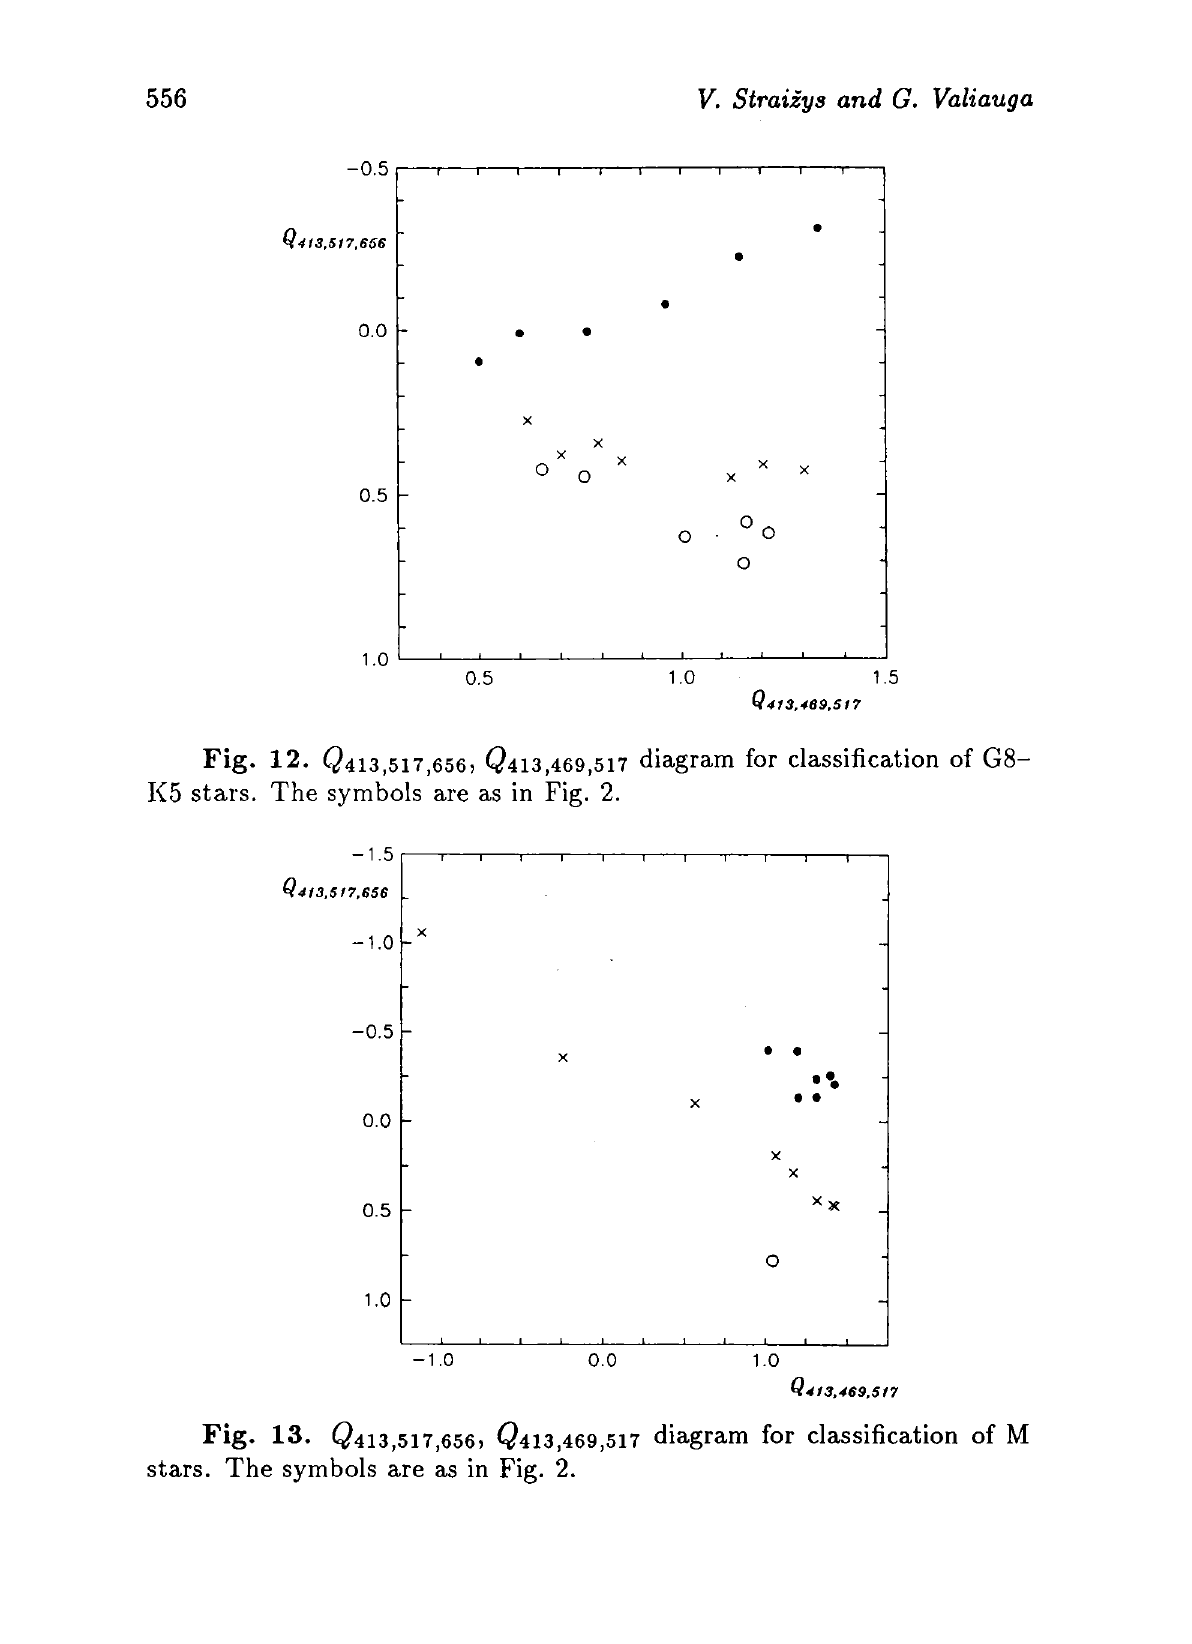
Fig. 12. $413,517,656, ^413,469,517 diagram for classification of G8- K5 stars. The symbols are as in Fig. 2.